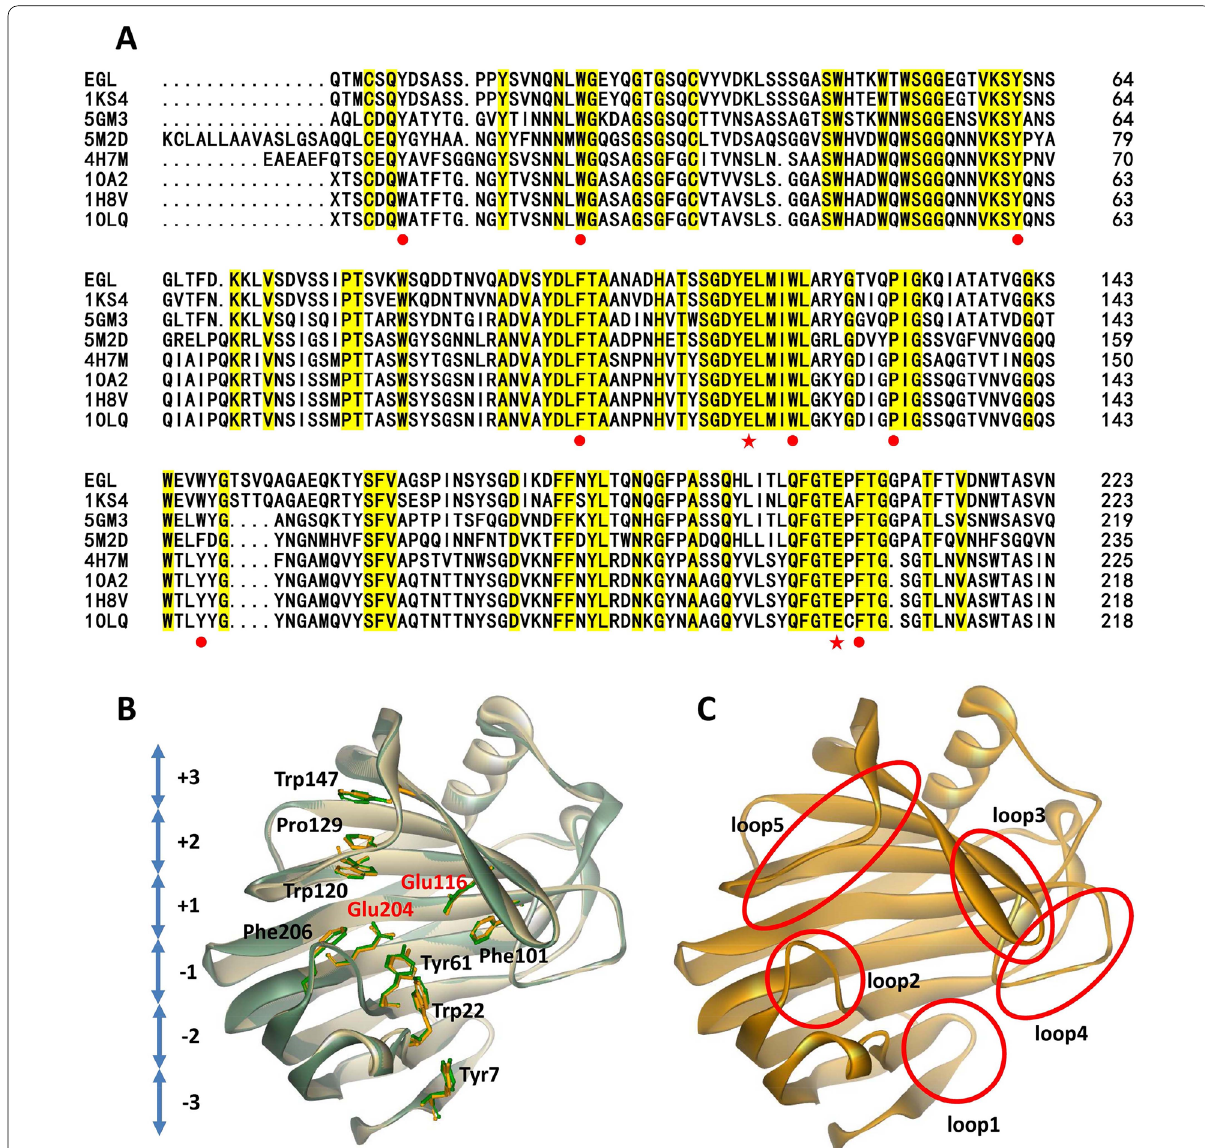
Fig. 3 Analysis on sequence and structure of An EGL. A Amino acid sequence alignment of EGLs. 1KS4, 5GM3, 5M2D, 4H7M, 1OA2, 1H8V, and 1OLQ are the PDB IDs of EGLs, 1KS4: EGL from A. niger , 5GM3: EGL from Aspergillus aculeatus , 5M2D: EGL from Acremonium chrysogenum , 4H7M: EGL from Trichoderma harzianum , 1OA2, 1H8V, and 1OLQ: EGLs from Trichoderma reesei . The residues with 100% homology level are highlighted with yellow. The substrate binding residues and catalytic residues of An EGL are marked with red solid circles and pentagrams, respectively. B Modeling structure and key residues of An EGL. The structures of EglA and An EGL are displayed with light green and light orange, respectively. Key residues of EglA and An EGL are displayed with green and orange, respectively. C Distribution of key loops involved in substrate binding